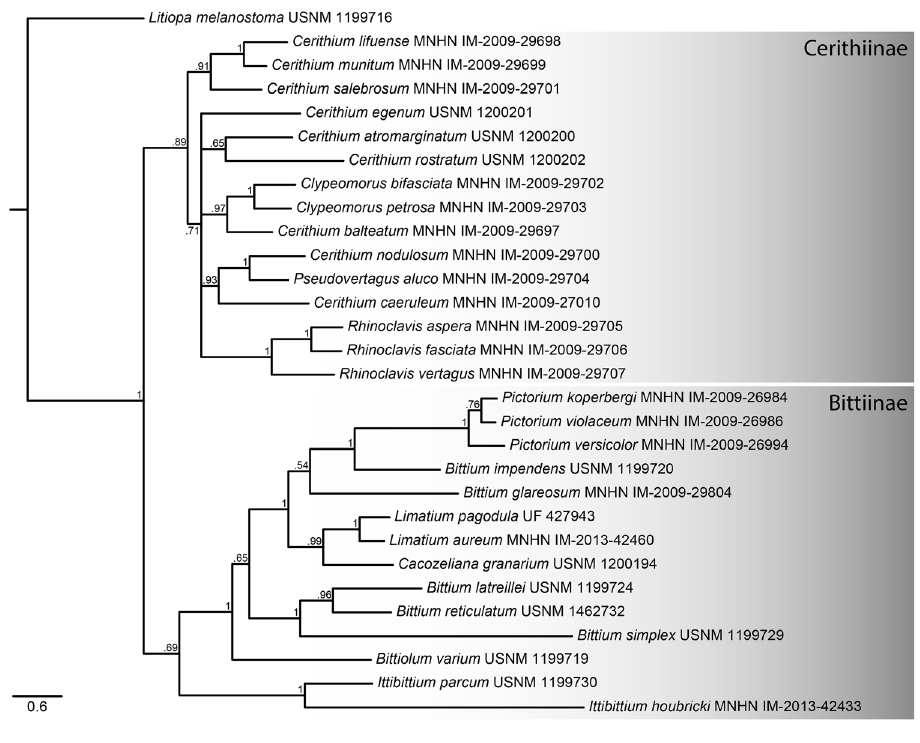
Figure 5. Phylogeny of Cerithiidae based on Bayesian analysis of partial COI and 16S sequences. Cata- logue numbers for vouchers indicated after species name. Posterior probabilities greater than .50 are shown at the nodes. See Table 1 for